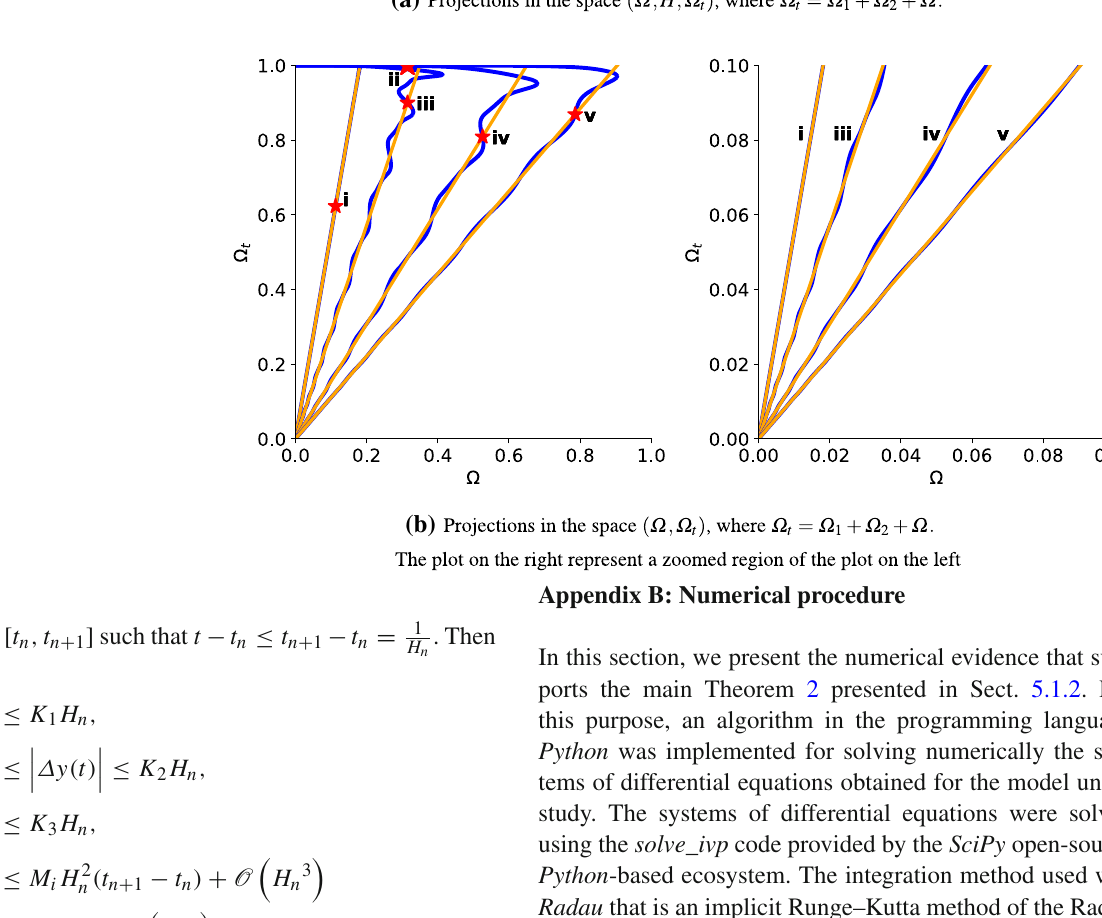
Fig. 7 Some solutions of the truncated system (B.22) (blue) and time-averaging system (B.23) (orange) for the fixed √ values of ω 1 = 2 and √ ω = 2 / 2. We use as initial 2 condition for both system the five data sets presented in Table 2. These plots are numerical evidence that the main Theorem 2 is fulfilled. That is, the solution of the truncated system follow the track of the solutions of the time-averaged system and the oscillations experimented by the truncated system are smoothed out as H →